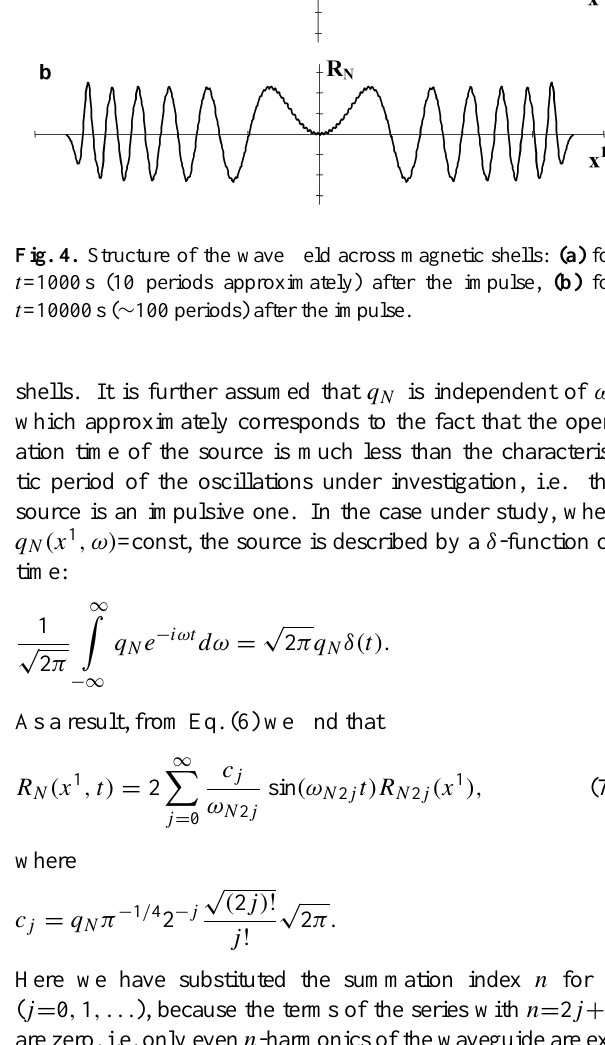
Fig. 3. Time-dependence of the wave field in the waveguide. Here t is time after the impulse.